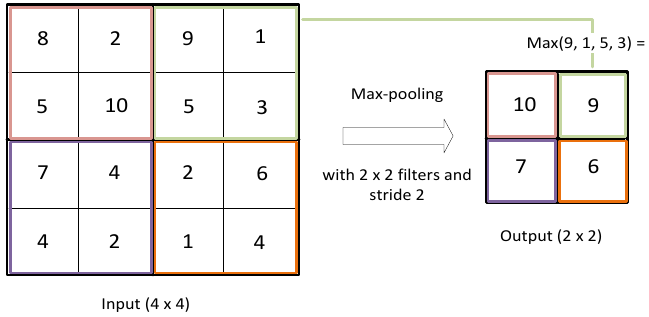
Figure 6. Max-pooling operation on radio images (2 × 2 window and stride